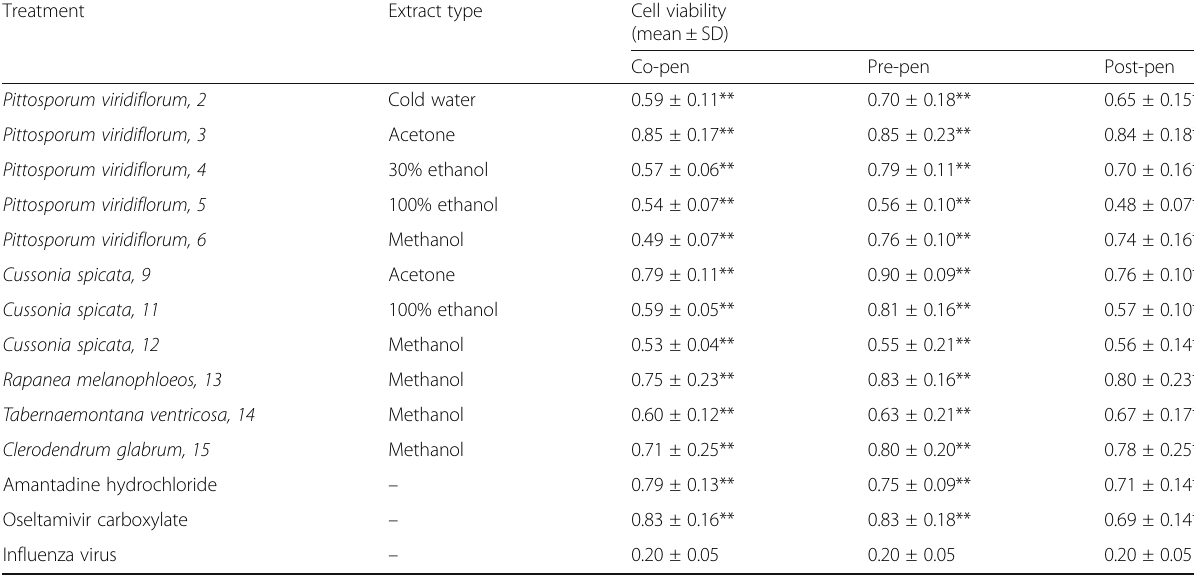
Table 4 Cell viabilities from MTT assay in combined treatments with virus compared to virus control group Treatment Extract